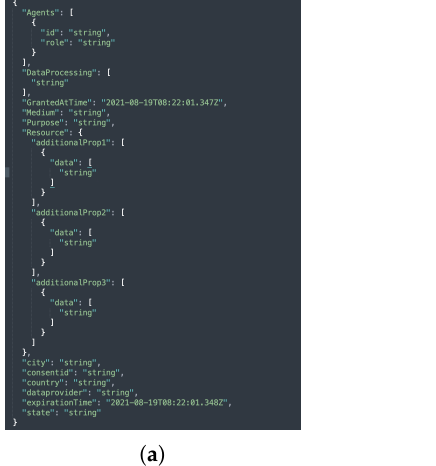
Figure 5. A snapshot of the JSON schema used for consent and the consent module’s creation (or representation) of consent in the legal KG. ( a ) Consent JSON schema. ( b ) KG representation of consent in GraphDB after successful